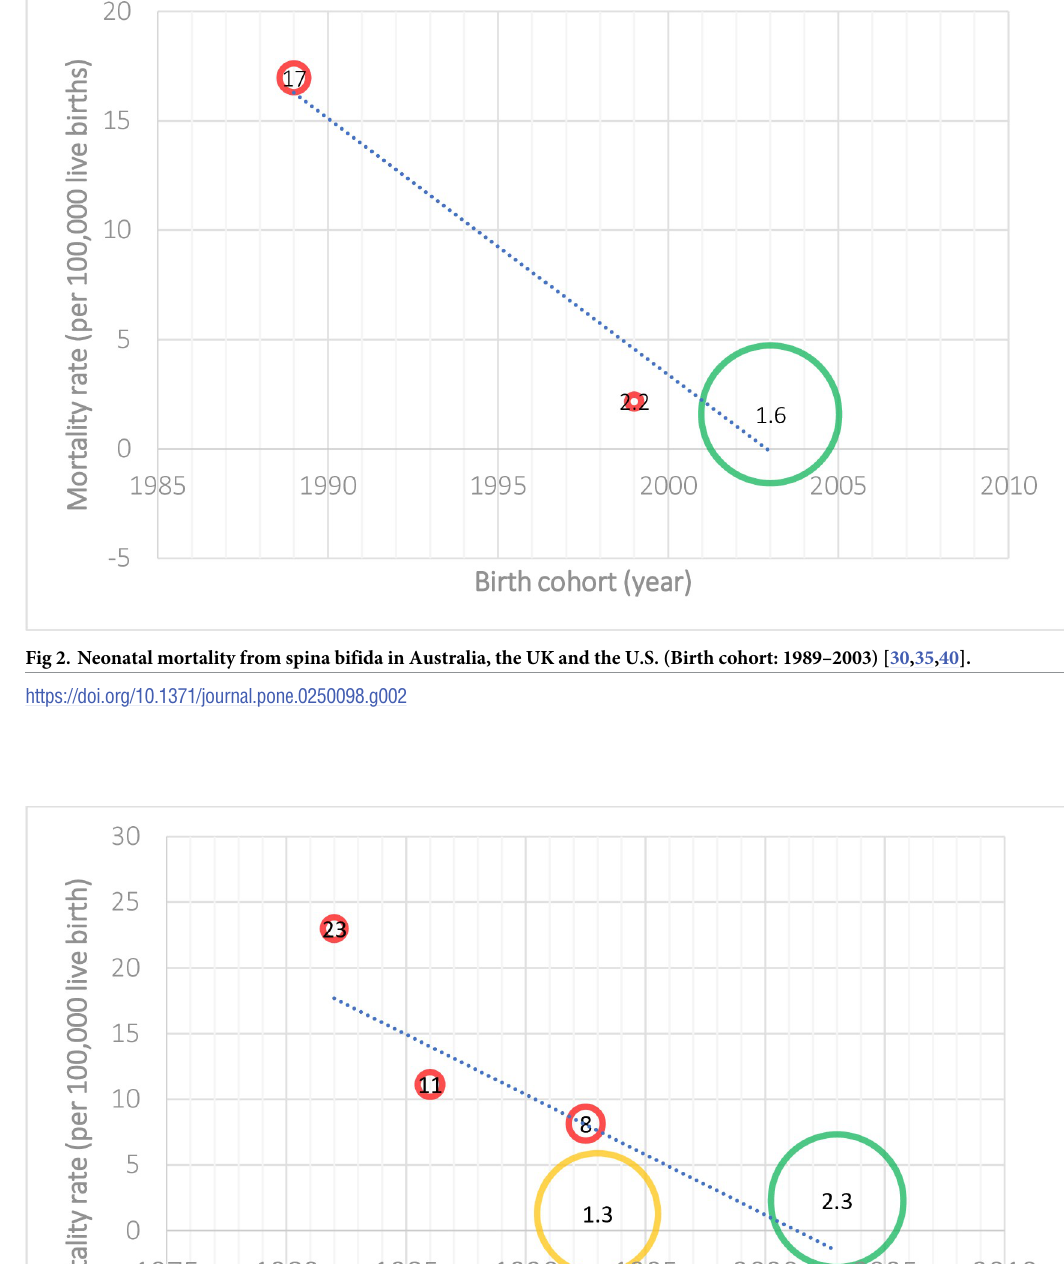
PLOS ONE | https://doi.org/10.1371/journal.pone.0250098 May 12, 2021 11 /